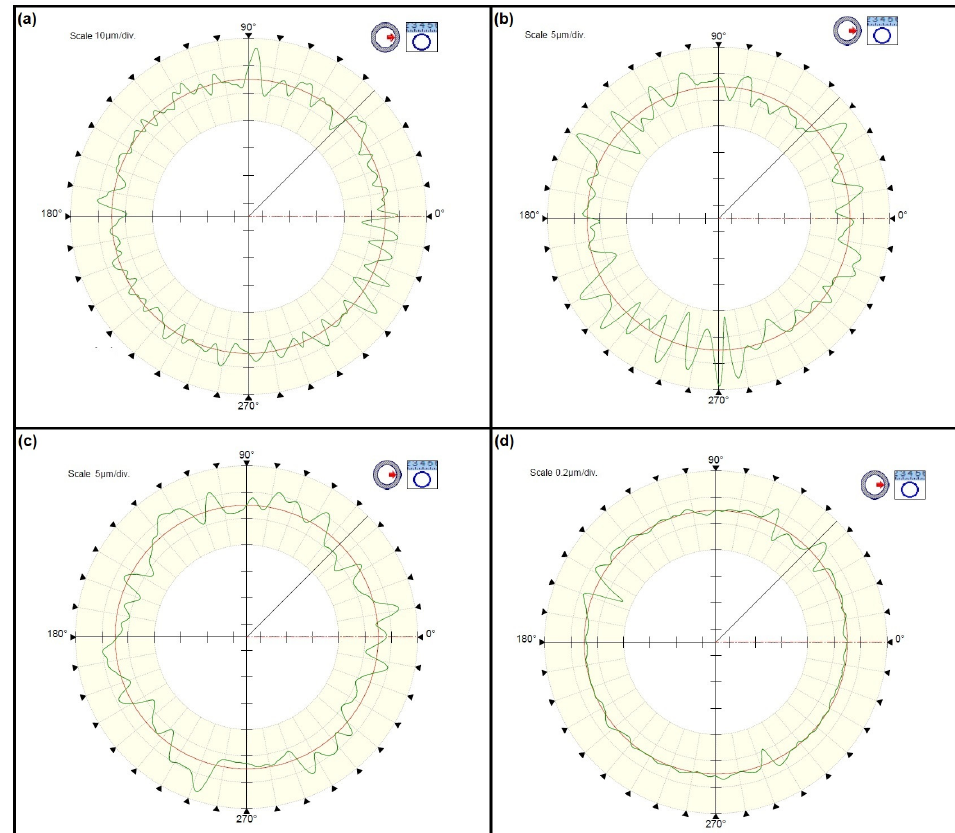
Figure 5. The waviness profiles of the outer ring races after the subsequent machining stages ( a ) forging, ( b ) turning, ( c ) heat treatment, ( d ) grinding. ( a ) forging, ( b ) turning, ( c ) heat treatment, ( d )